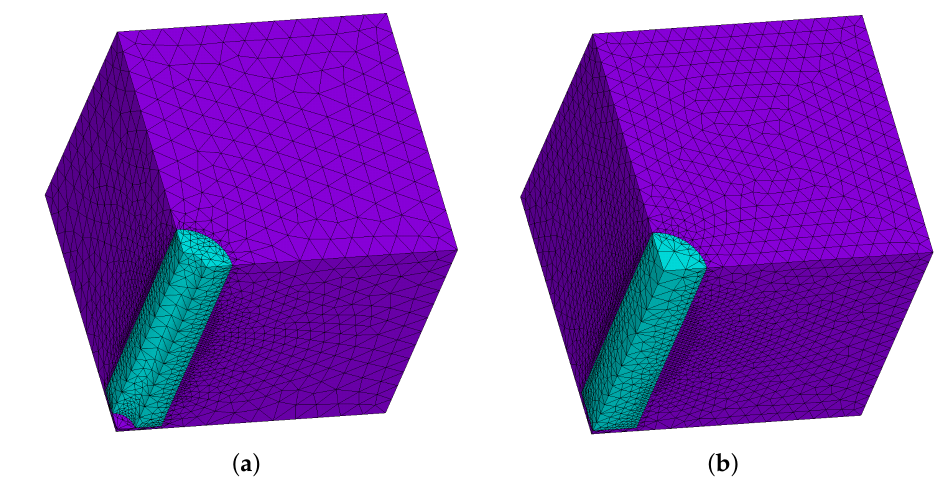
Figure 4. Discretization for one-eighth of the periodic cells using ANSYS (Solid187 element) with